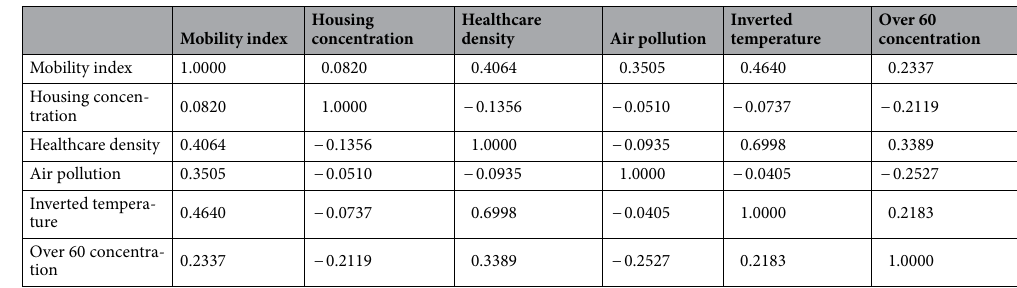
Table 2. Pearson correlation coefficients among the indicators x 1 , . . . , x 6